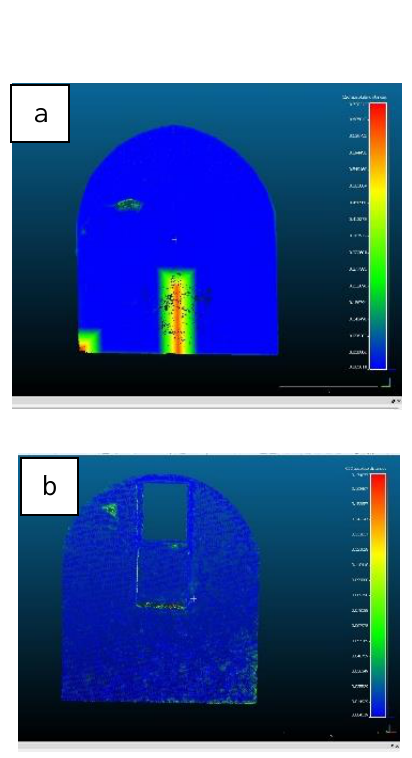
Figure 8 . Discrepancy (m) map between the TLS2021 and CRP2021 point cloud for Presbytery (a) and 6 chapel